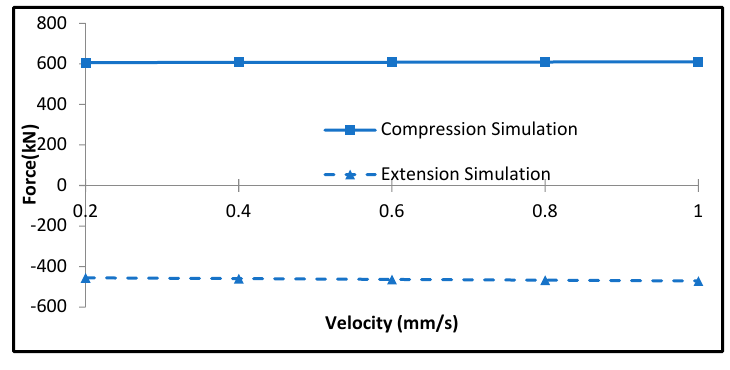
Figure 9. Off-state damping force.